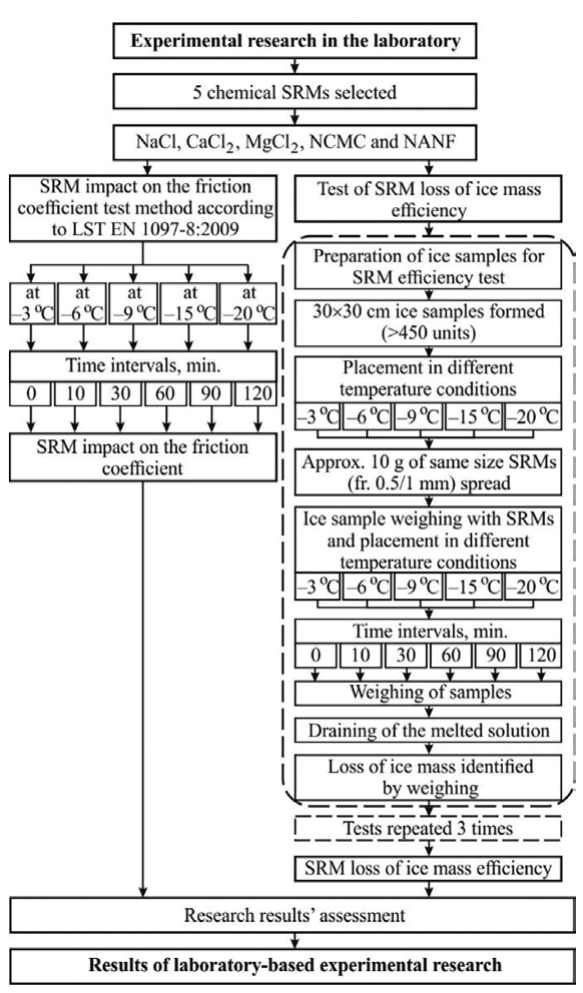
Fig. 2. Laboratory-based experimental research plan (compiled by the author Ratkevičius, T)